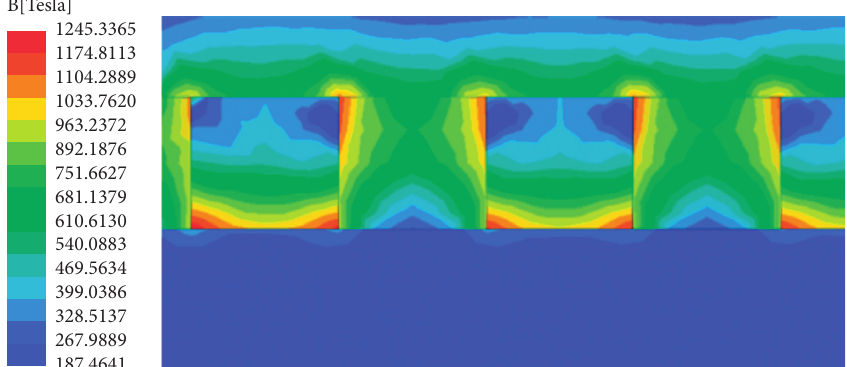
Figure 13: Cloud diagram of finite element of magnetic flux density of the RPMS.